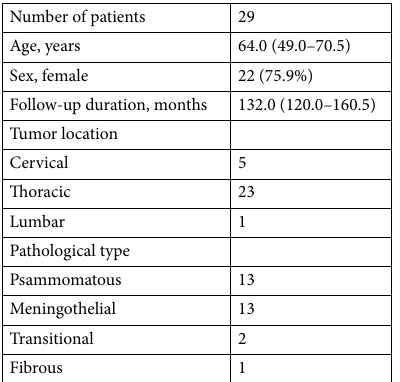
Table 1. Patients’ characteristics. All patients were World Health Organization (WHO) grade 1. Data are presented as number, number (%), or median (interquartile range).